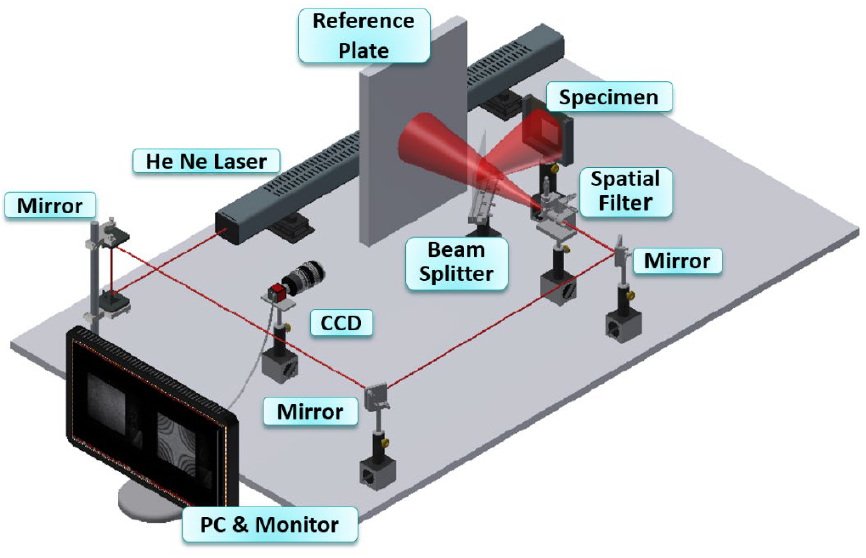
Figure 2. Out-of-plane setup in ESPI.